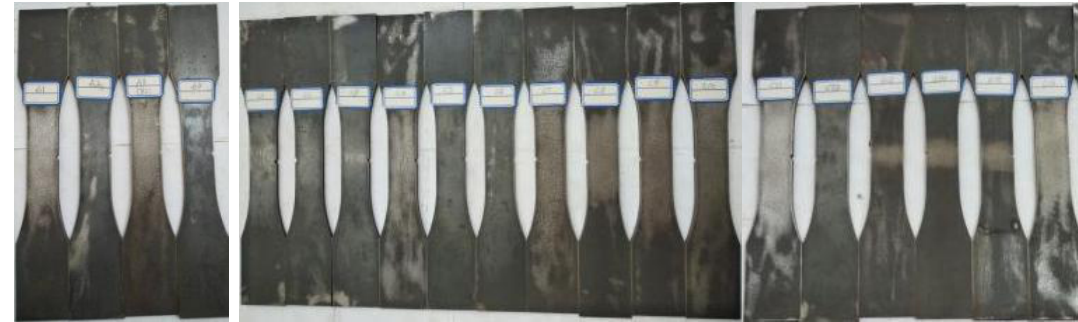
Figure 2. Pictures of the Q460C steel notched plates. Table 1. Geometry and loading parameters of the Q460C steel notched plates.